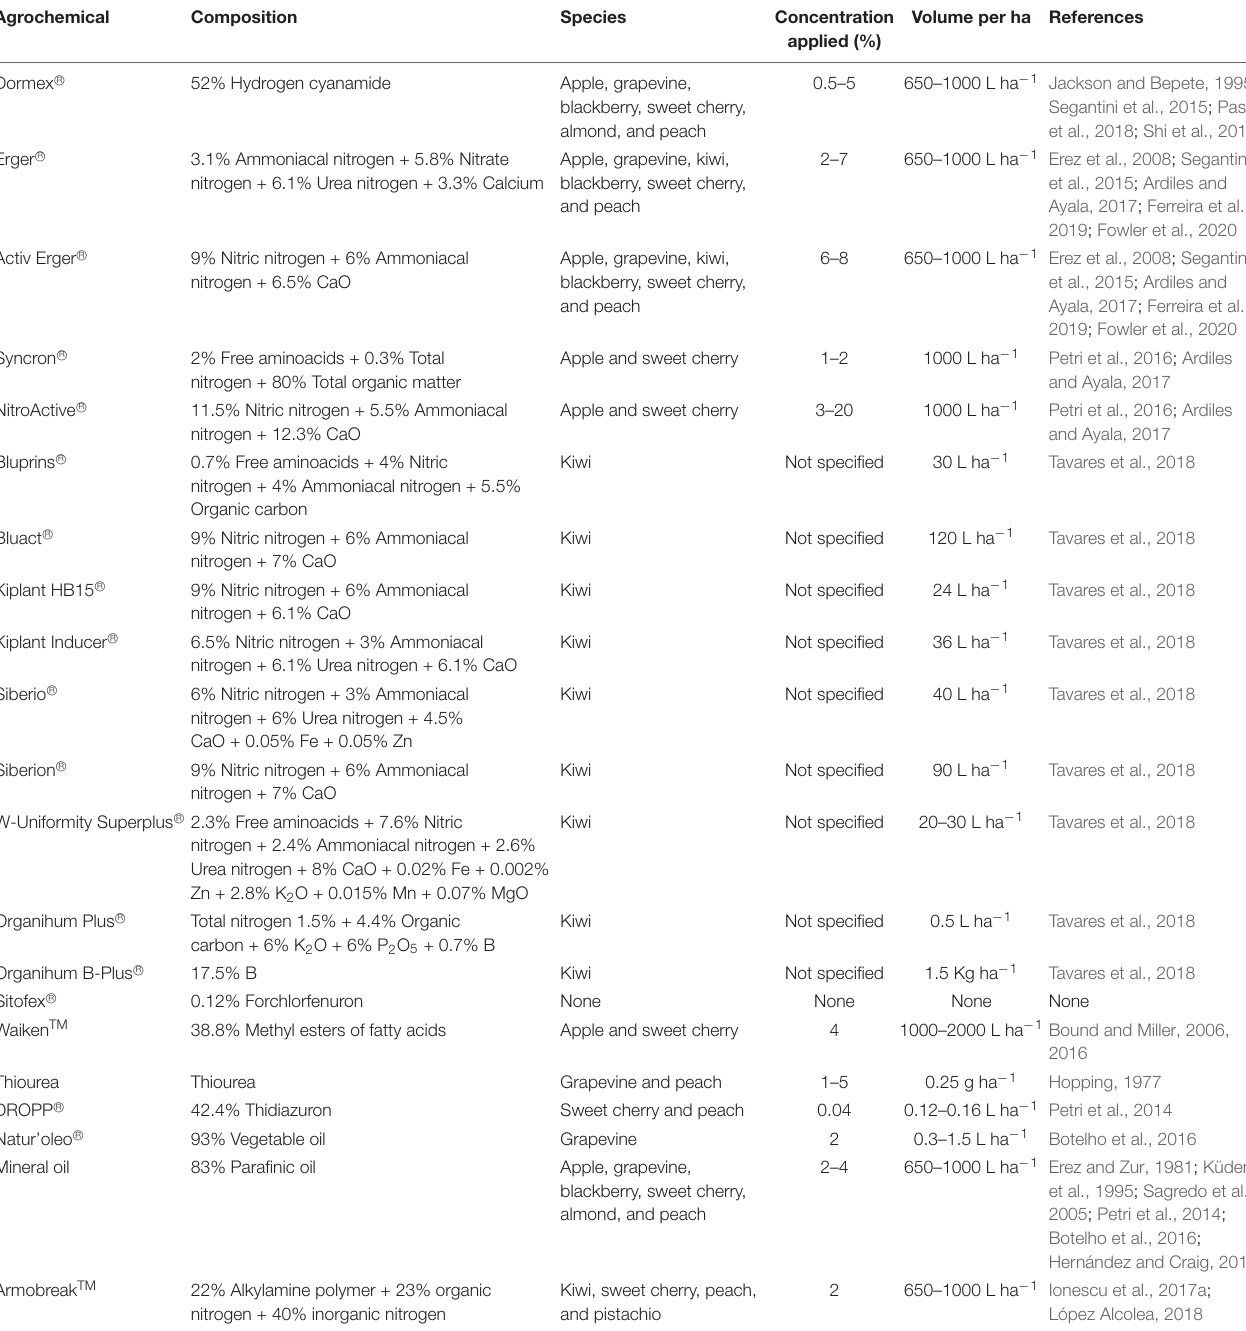
TABLE 1 | Composition of the different agrochemicals used for advancing endodormancy release and species in which they have been tested. Agrochemical Composition